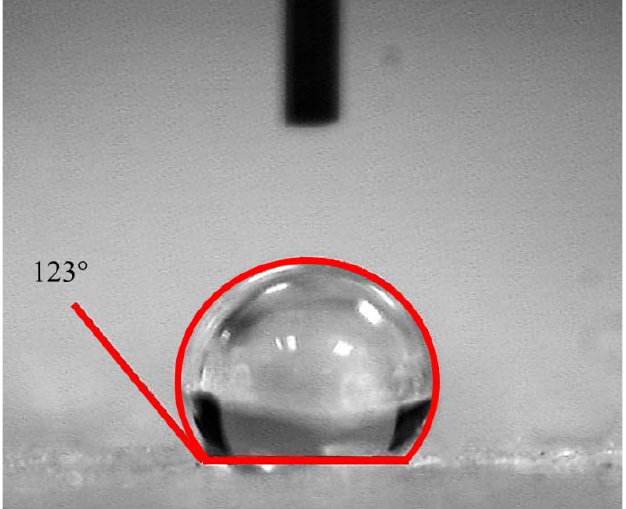
Figure 6. Water contact angle measurement on the coated surface of the aluminum - based aerogels.